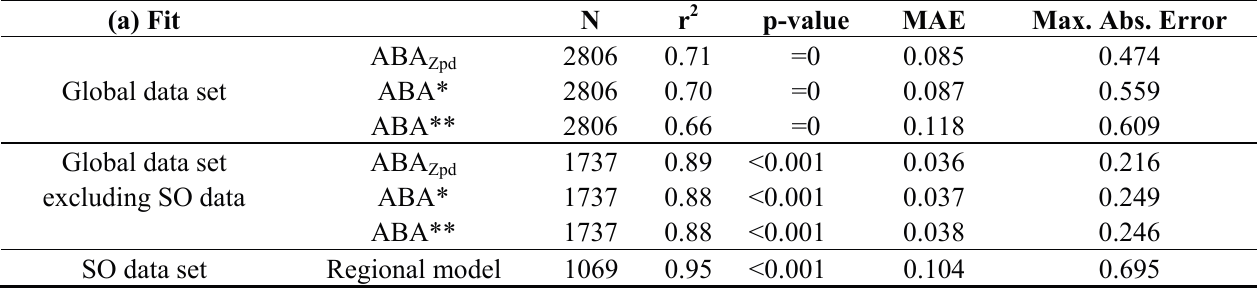
Table 5. Statistical results of the fits for the global data set and global excluding SO data